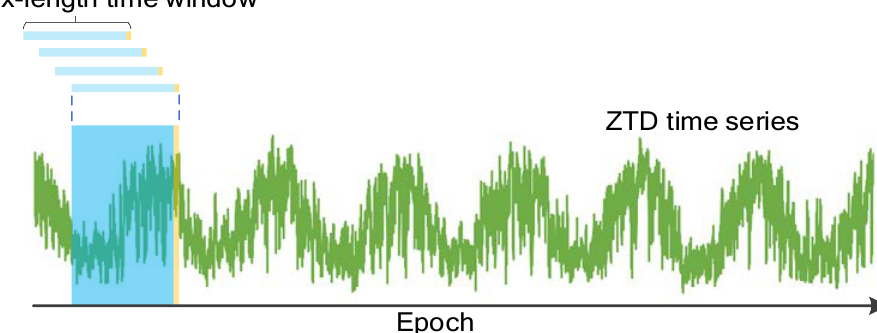
Figure 8. Construction of a supervised learning forecast ZTD model diagram through a fixed-length